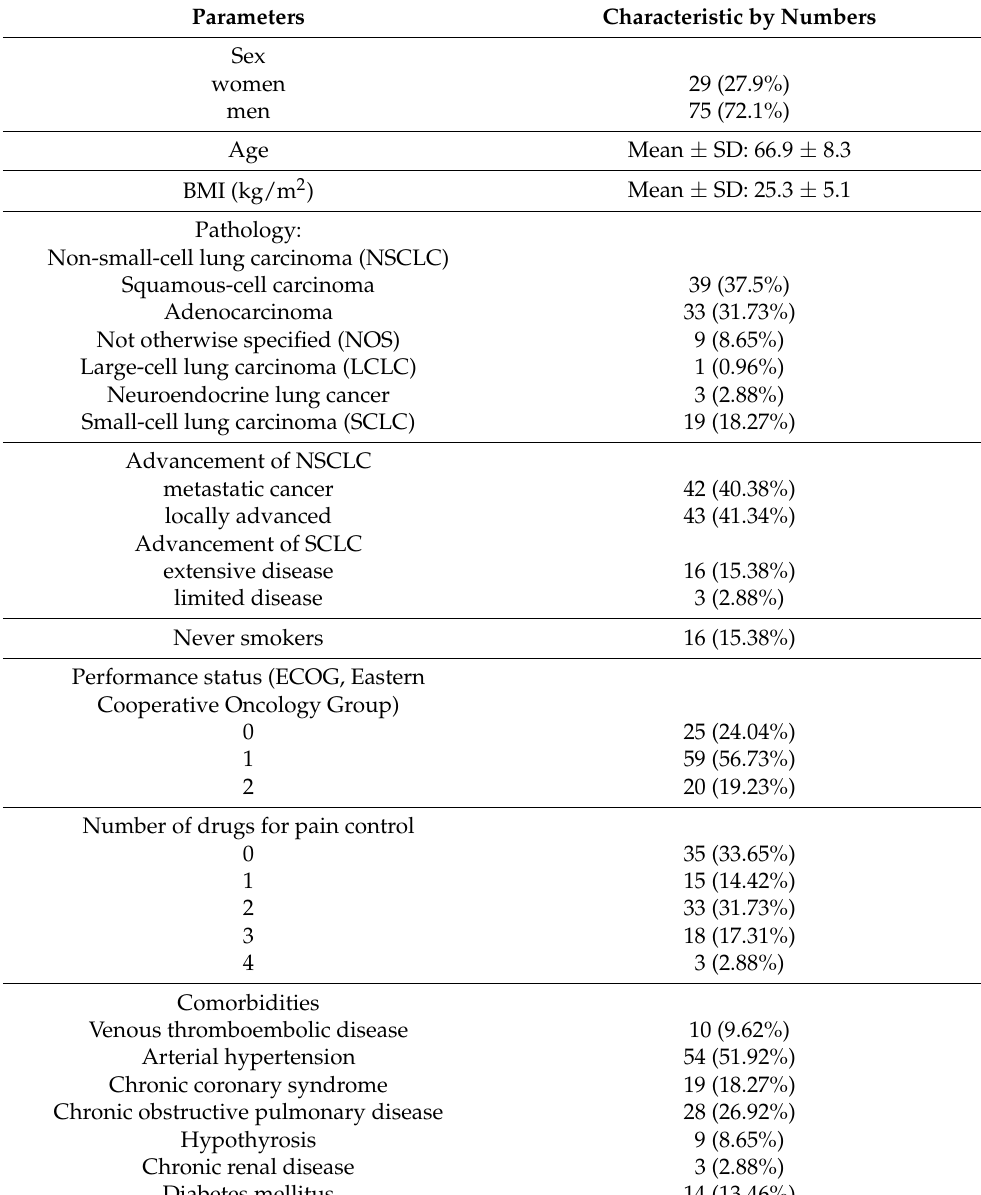
Table 1. Characteristics of lung cancer patients included in analyses of